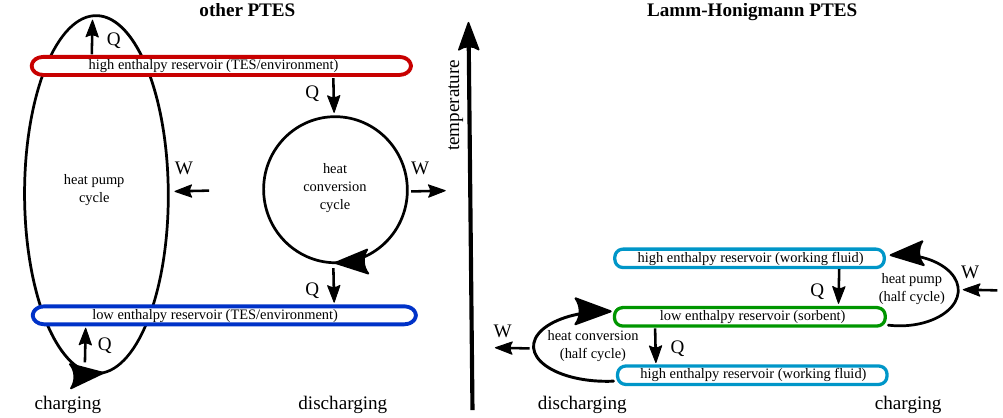
Figure 1. Schematic comparison of temperature levels of the high- and low-enthalpy reservoirs in LAHMA energy PTES compared to another PTES including driving temperature differences for the heat